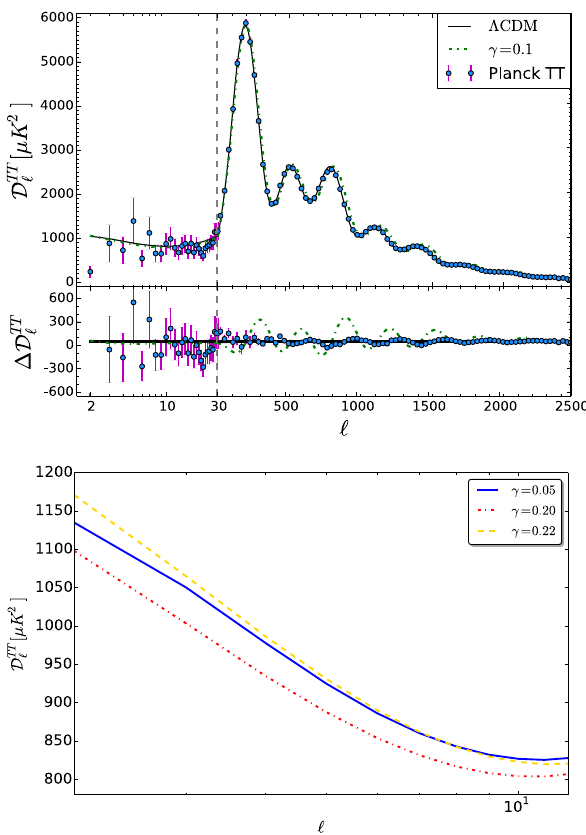
Fig. 16 Upper panel CMB power spectrum for bulk viscous and Λ CDM model. Lower panel the viscous coefficient leads to ups and downs in power spectrum for higher (cid:24) while for small (cid:24) due to ISW contribution the plateau of power varies depending on value of